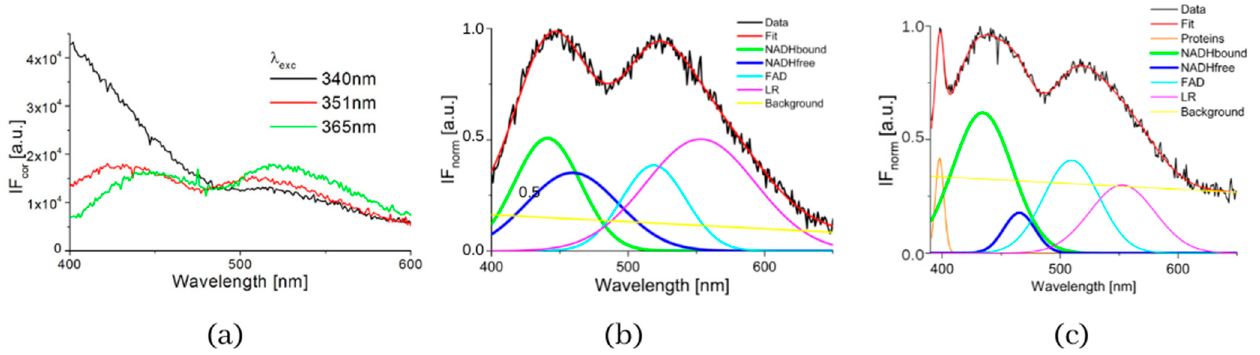
Figure 1. ( a ) Fluorescence spectra of suspension of living human liver carcinoma cells SNU475 (c = 2 × 10 5 cell/mL) in PBS excited at 340, 351 and 365 nm, ( b ) GASpeD decomposition of the normalized fluorescent spectra excited at 365 nm, ( c ) GASpeD decomposition fluorescence spectra excited at 351 nm.